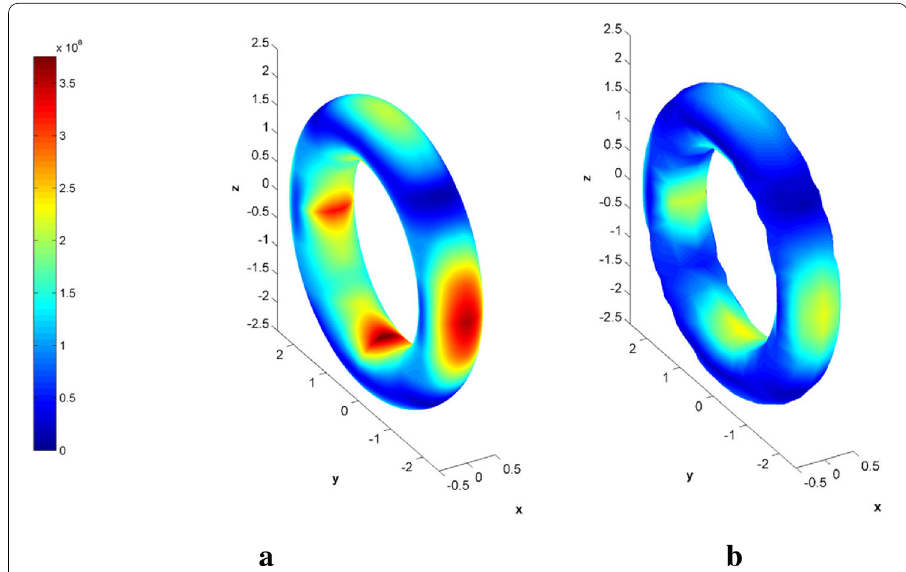
Fig. 17 Example 3. Small deformations contact between three torus. Von Mises stress for the central torus (Pa) with exact geometry consideration and linear facets. a Facets, 216 nodes. b Facets, 1052